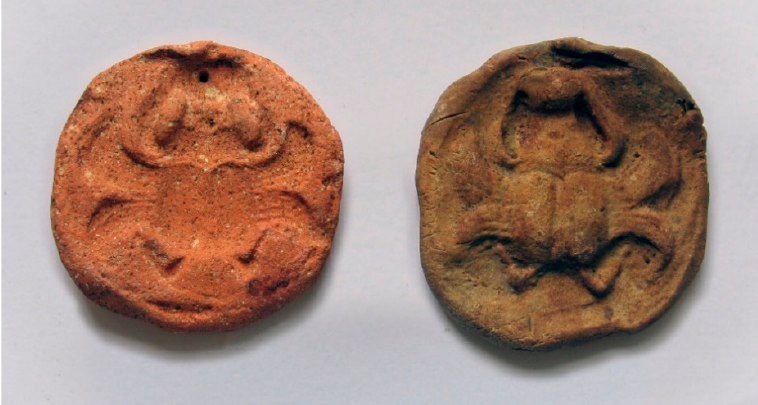
Figure 23. Egyptianizing scarab beetle (MGW inv. no. 3119) and modern imprint; terracotta mold; ca. 5th century BCE .